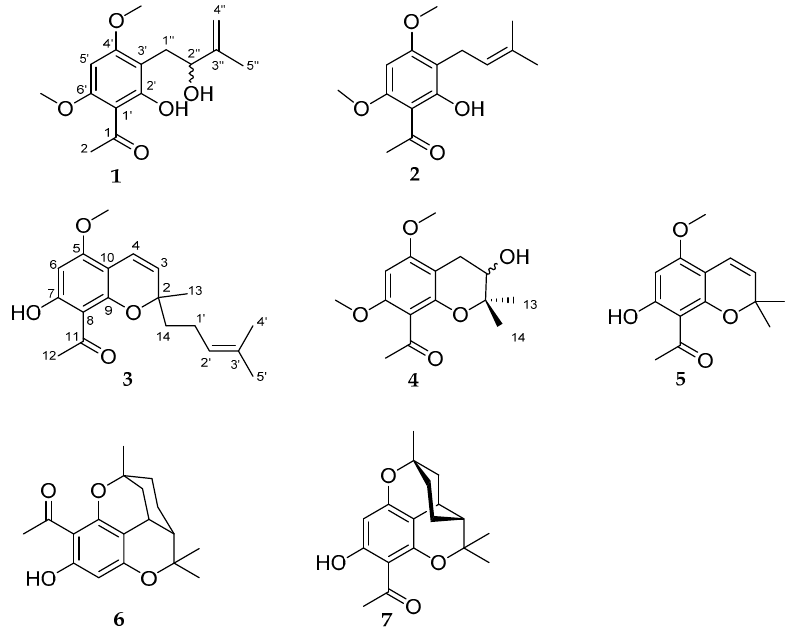
Figure 1. Structures of compounds 1 − 7 isolated from the leaves of Melicope